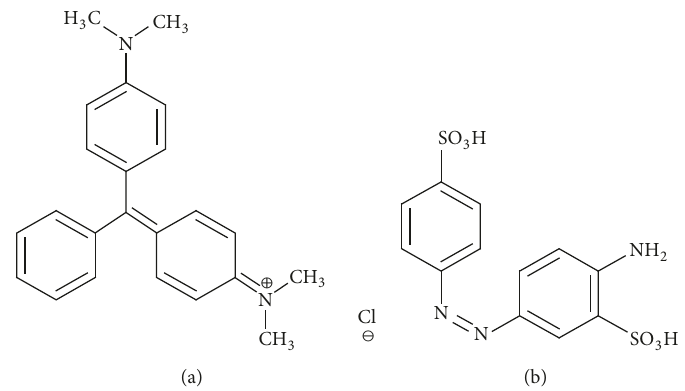
Figure 1: Chemical structure of (a) malachite green and (b) Remazol yellow